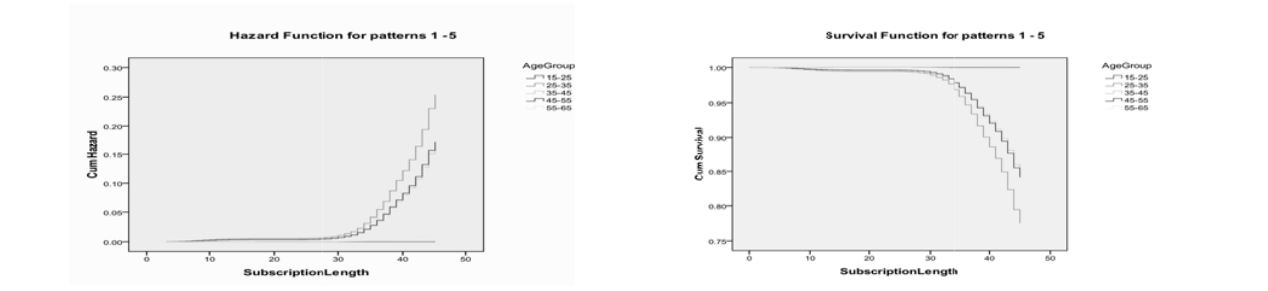
Fig. 3. Cus ups Fig.